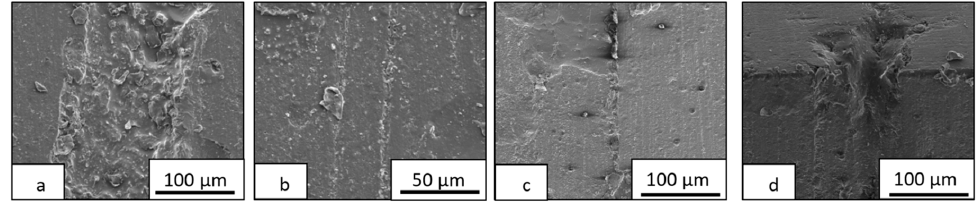
Figure 9. FEG-SEM images of self-healed samples with di ff erent initial width of crack close to 160 µ m ( a ), 38 µ m ( b ), and 10 µ m ( c ); and the end of the crack ( d